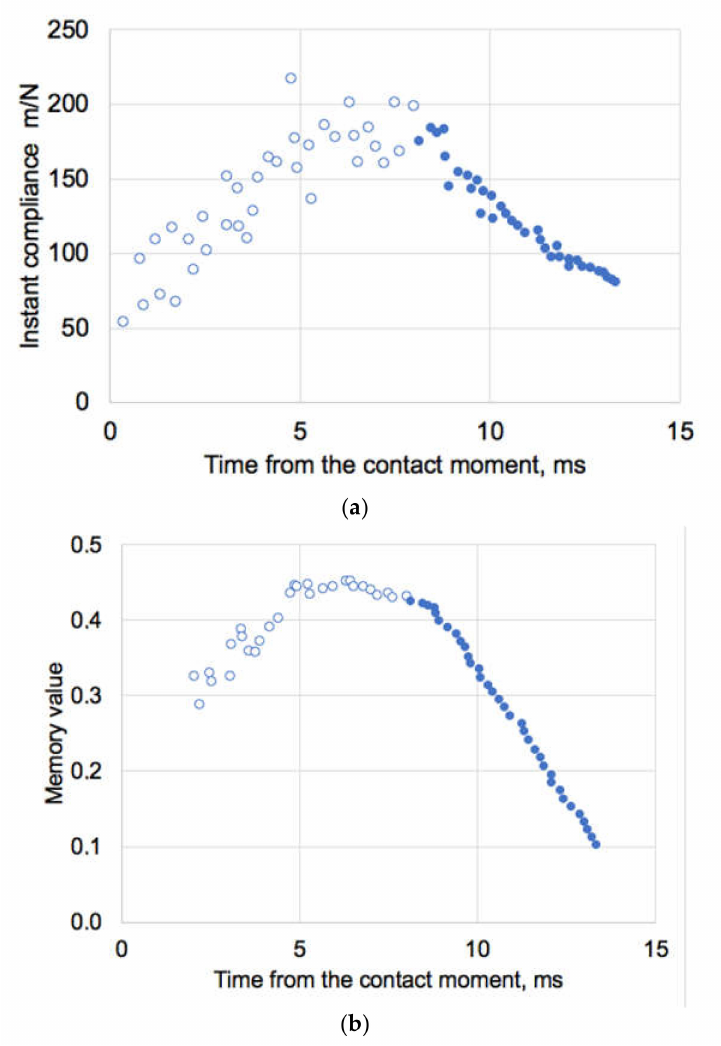
Figure 9. ( a ) Instant mechanical compliance (m/N) of IAV by AFM recalculated from data [36] and ( b ) respective memory values. Open symbols are for Phase I and closed for Phase II deforma- tion as presented in [36]. Maximal compliance values are in this case corresponding to maximal memory